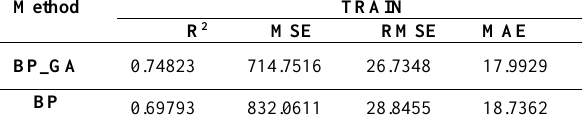
Table 4. Evaluation of BP, BP-GA (Train phase).